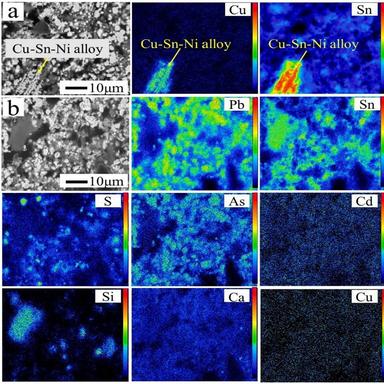
Element distribution in water leaching residue via EPMA.